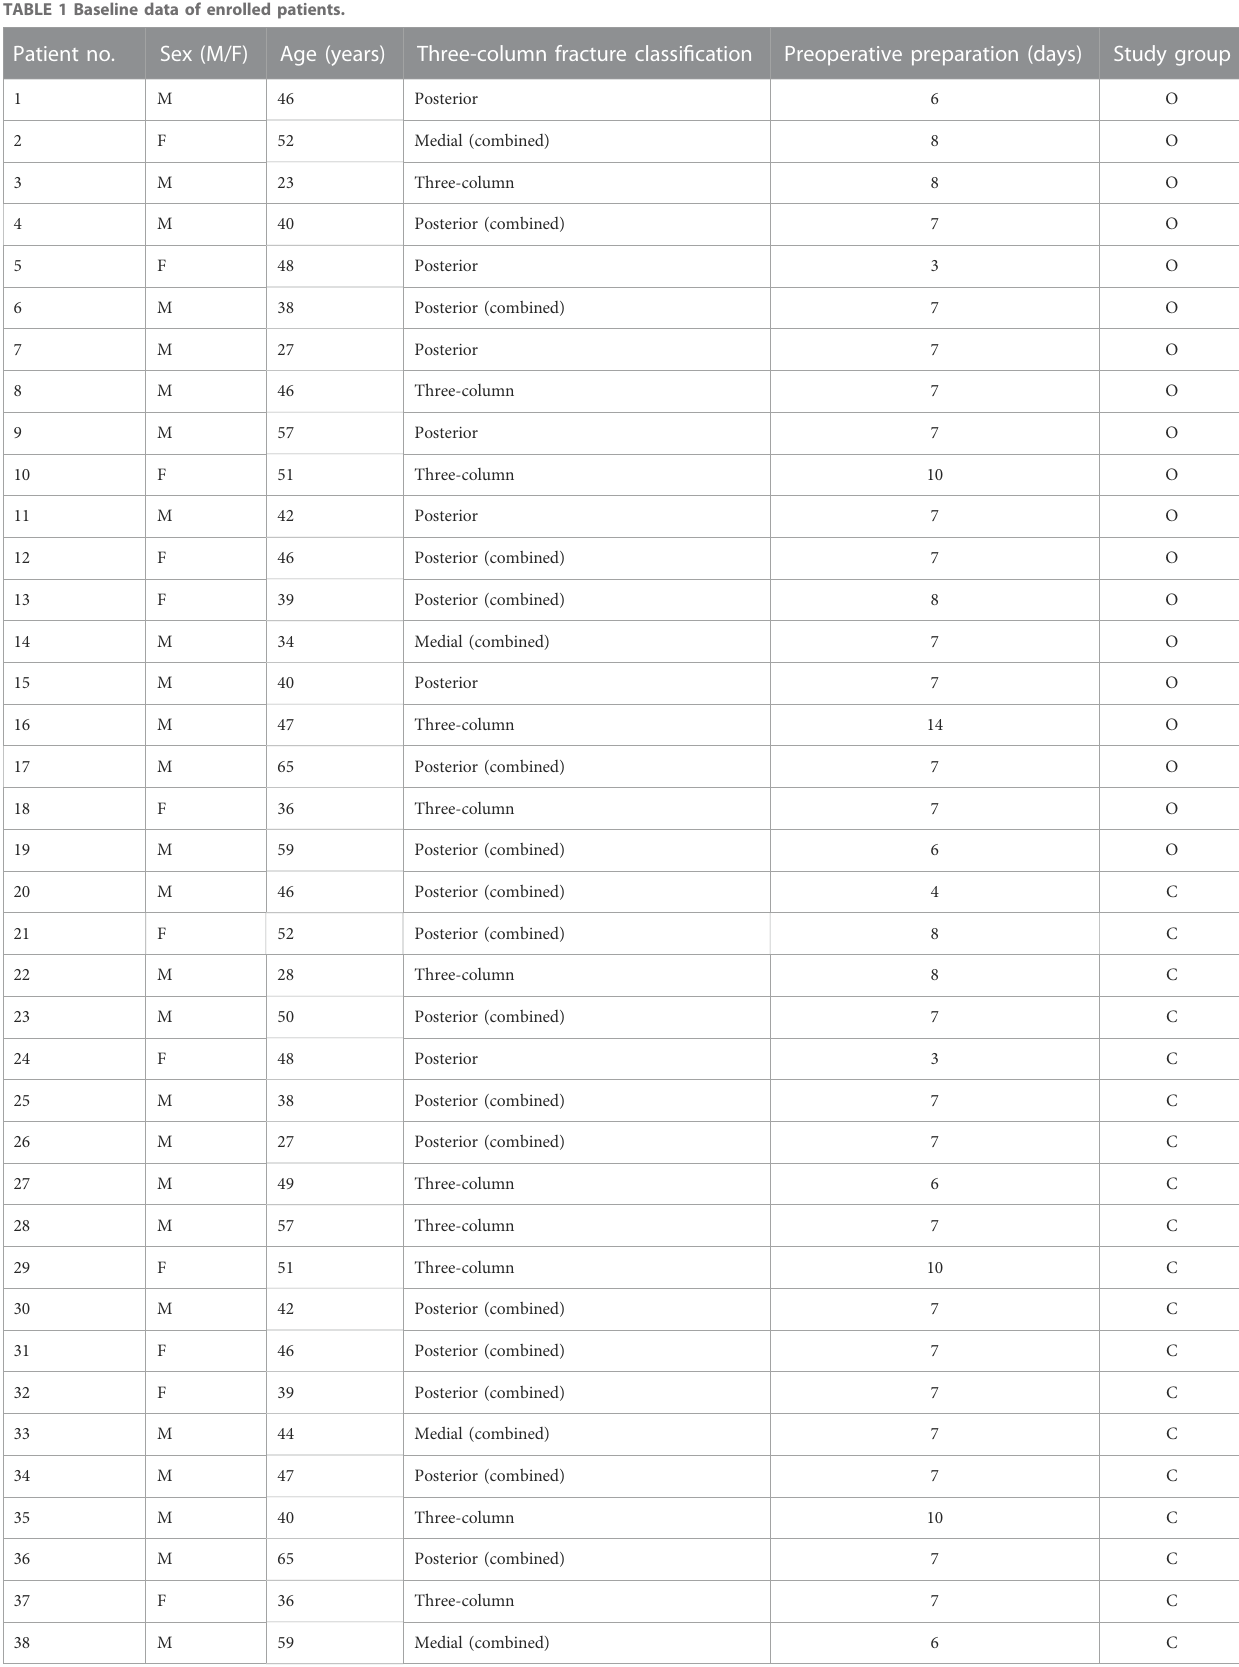
TABLE 1 Baseline data of enrolled patients. Patient